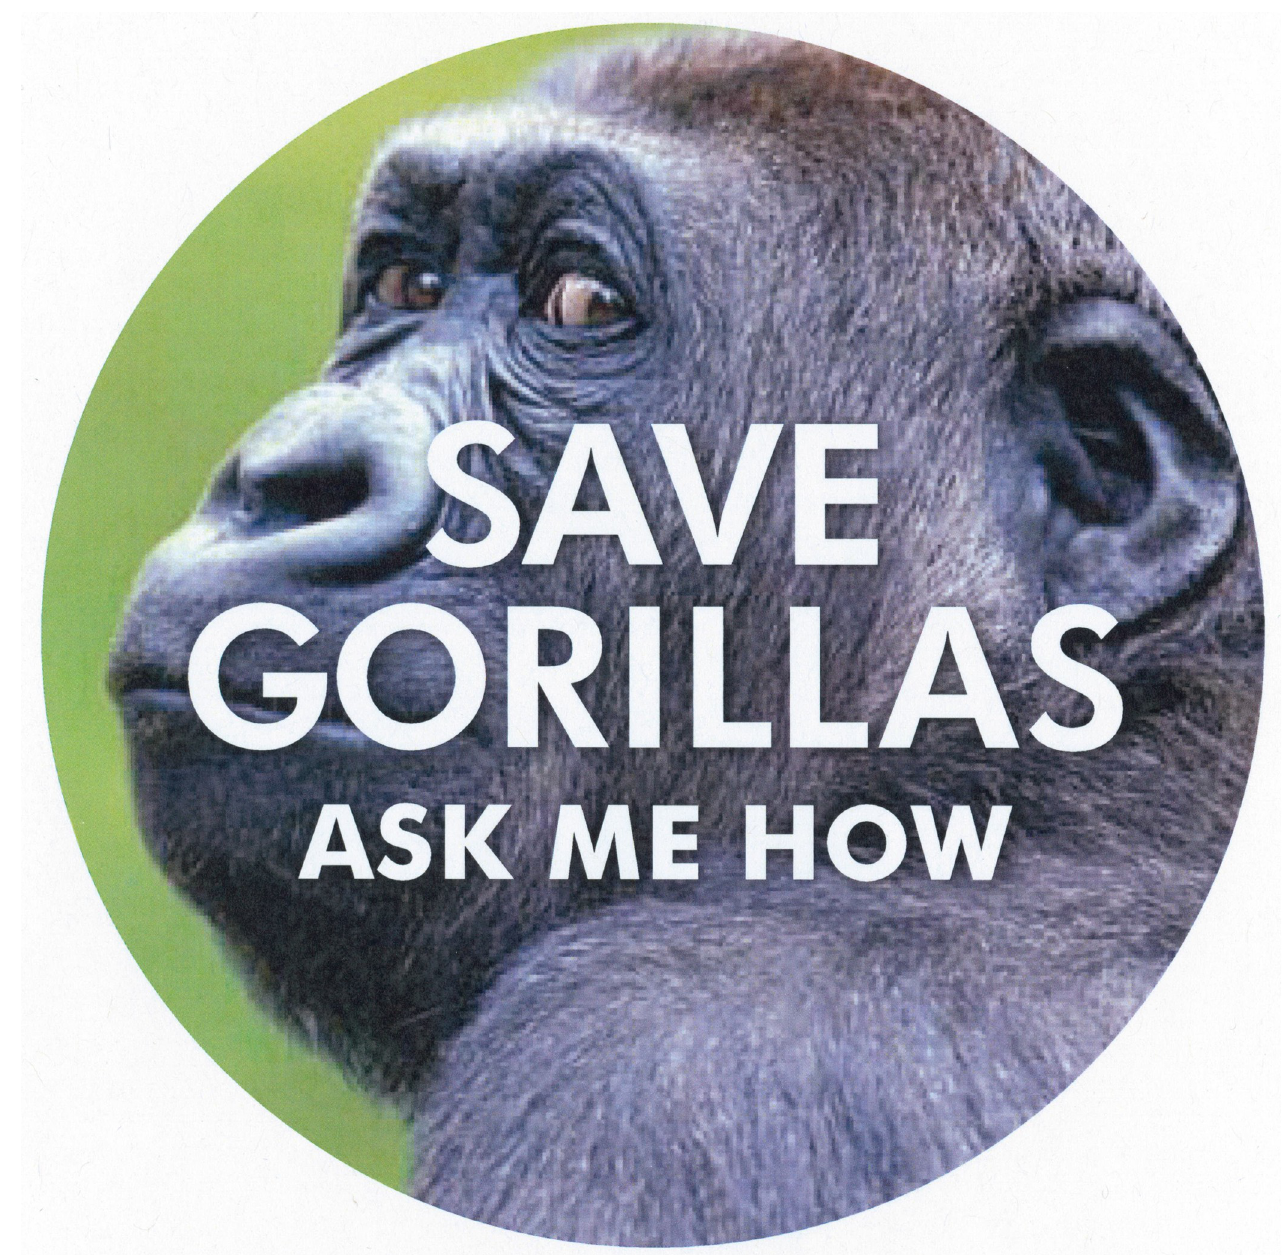
Fig 3. Artwork for staff uniform button badges work during the first year of the